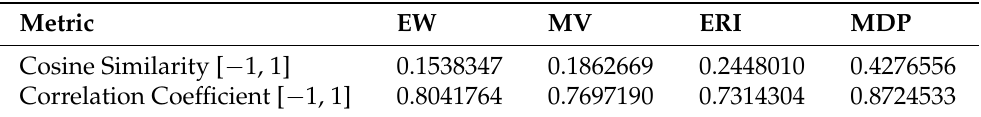
Table 3. Comparing DR to